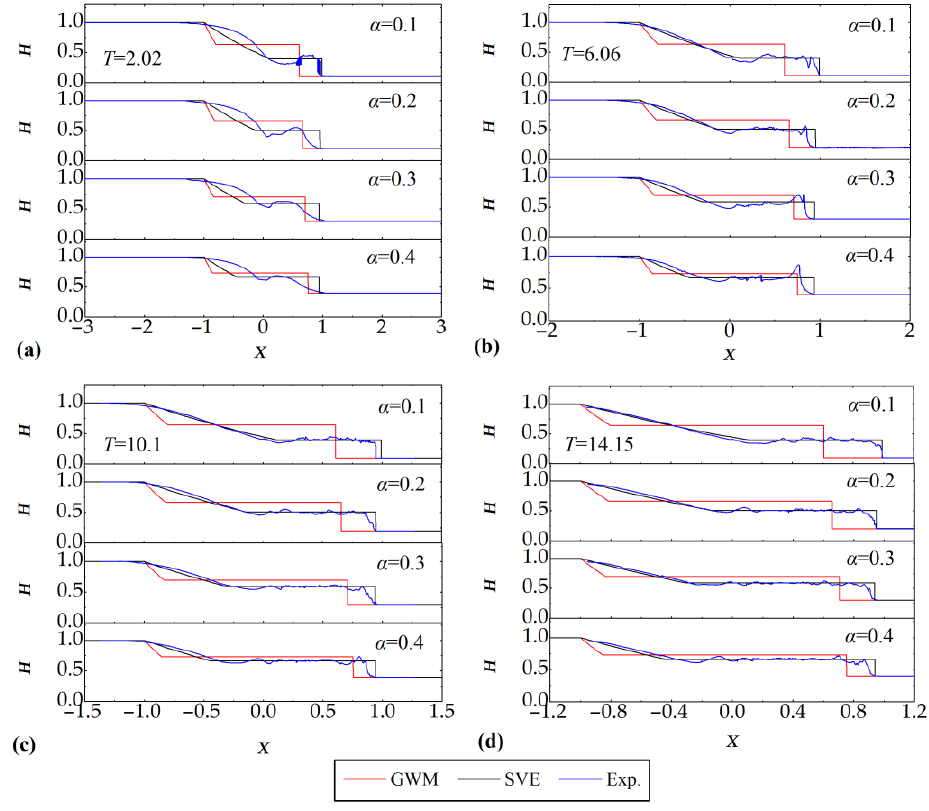
Figure 8. Water depth for wet bed downstream: ( a ) T = 2.02; ( b ) T = 6.06; ( c ) T = 10.1; ( d ) T = 14.15.